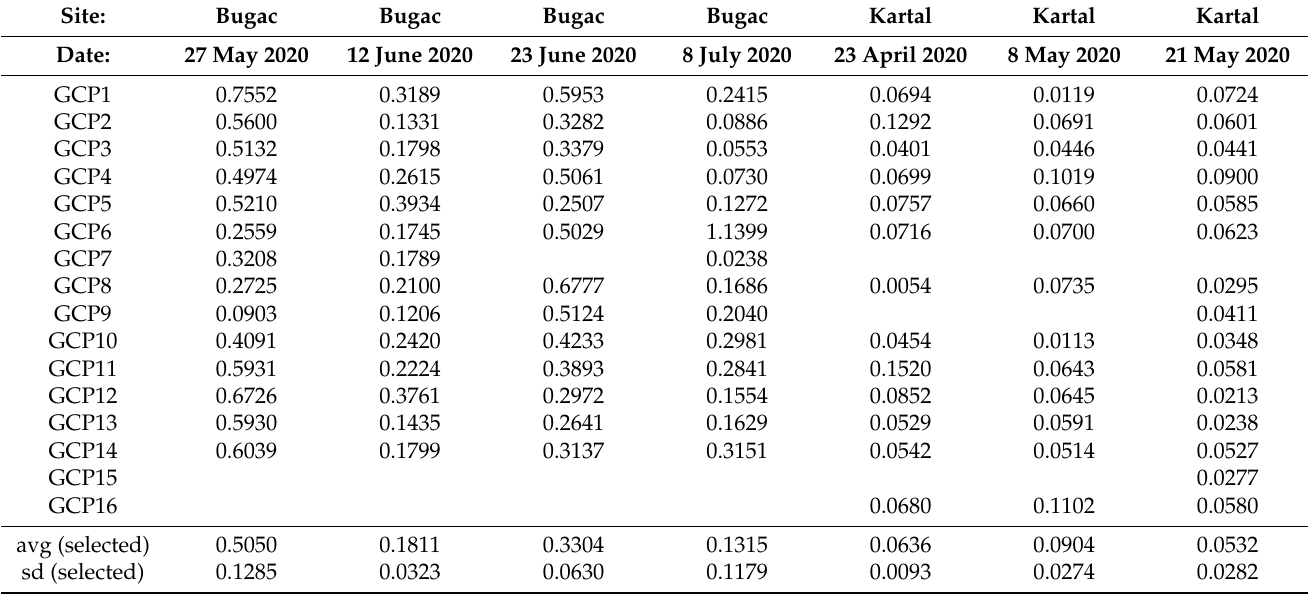
Table 4. Distance (m) of the GCP positions saved from the orthomosaics and their measured positions. The avg and sd (selected) variables are calculated only from the GCP positions excluded from the mosaicking